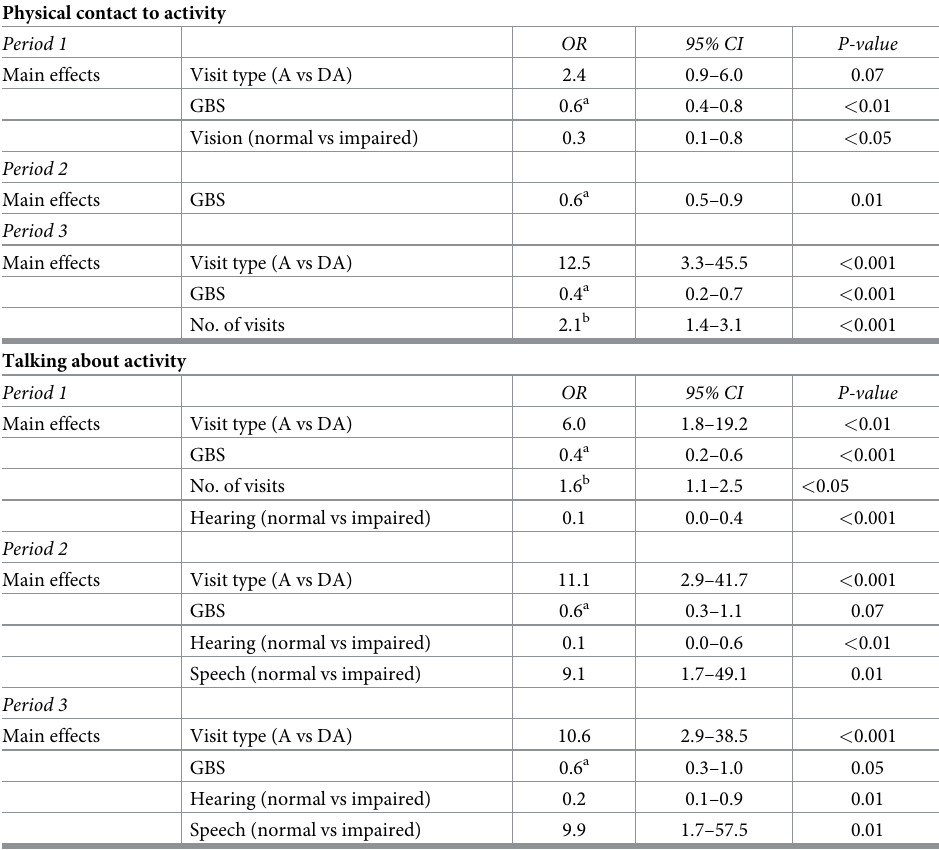
For each of the three periods, the estimated odds ratios (OR), the 95 confidence intervals (95% CI), and the P-values are shown for significant effects. Visits with a dog, with activity (DA), Visits without dog, with an activity (A). The Gottfries-Br å ne-Steen Scale (GBS). a For an increase of 20 on the GBS scale, b For an increase of 1